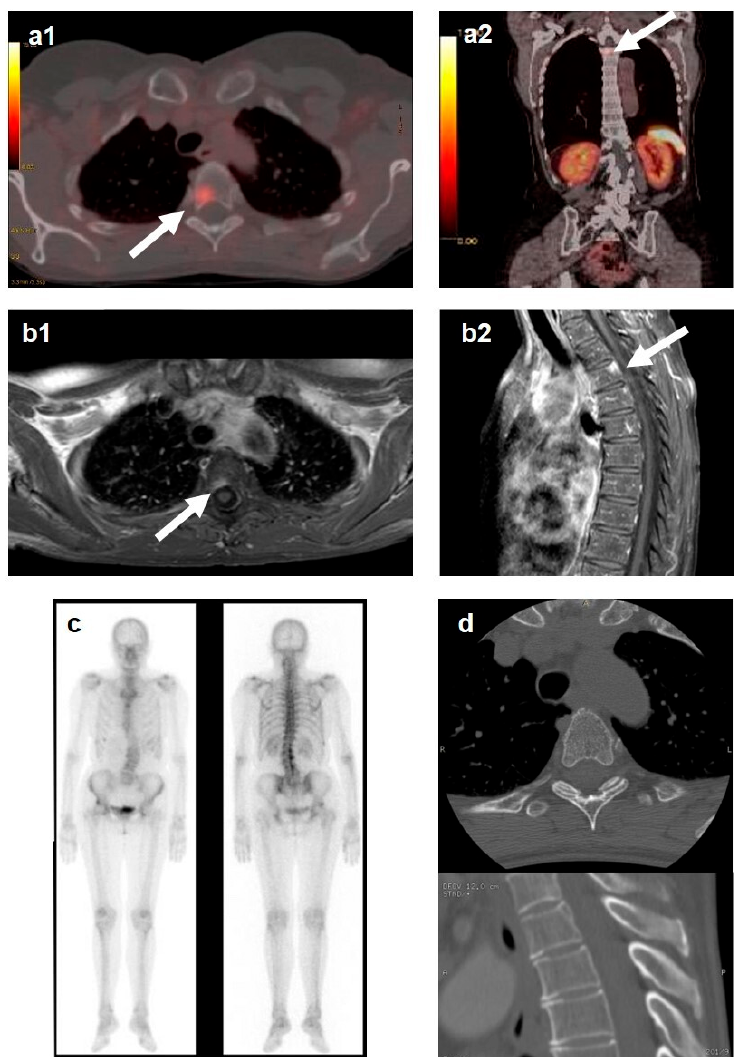
Figure 2. Thoracic vertebrae (T4) bone metastasis (BM) was diagnosed two years after a liver metastasis in a 66-year-old woman with a history of ileal neuroendocrine neoplasm. Somatostatin